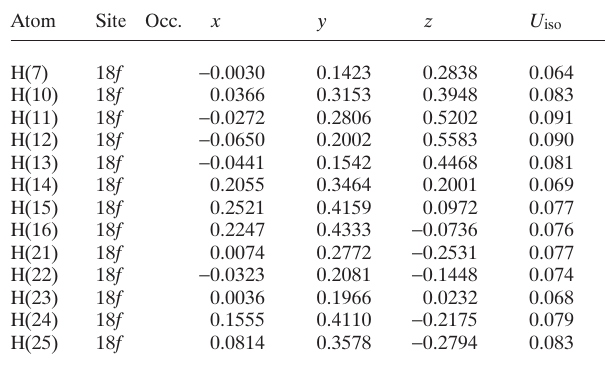
Table 2. Atomic coordinates and displacement parameters (in Å 2 ) . Atom Site